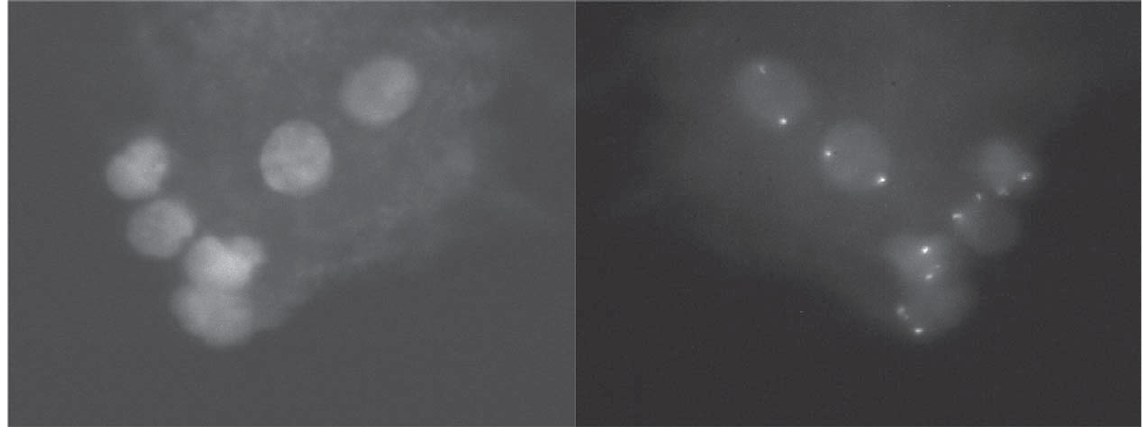
Fig. 8. FISH image taken by the presented system in real time (at 30 frame rate). On the left is the image of the DAPI (blue) and on the right is the image of the spectrum